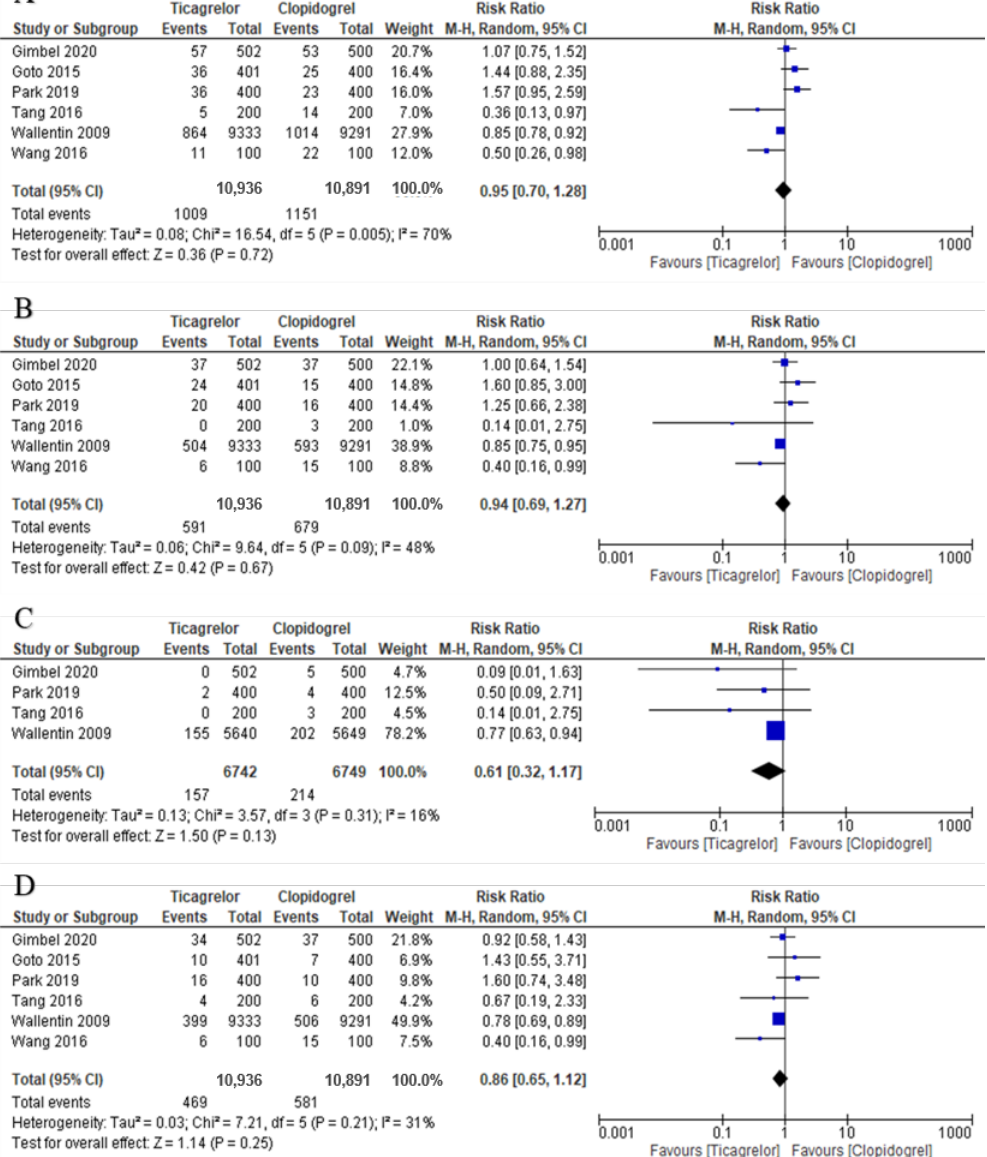
Figure 3. The forest plots for ( A ): MACE; ( B ): MI; ( C ): stent thrombosis; ( D ): all-cause mortality in elderly patients treated with Ticagrelor versus clopidogrel.